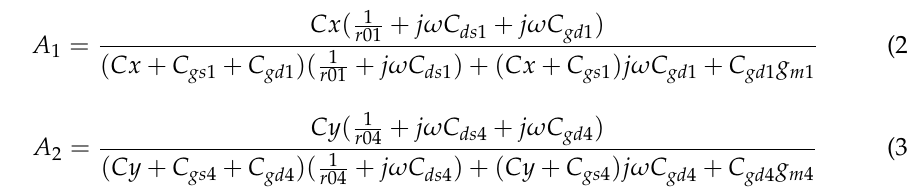
Figure 2. ( a ) Schematic of the proposed reconfigurable digitally controlled VGA and ( b ) diagram of the structure of the asymmetric capacitors C x and C y , where C x is an adjustable capacitor and C y is a fixed capacitor.